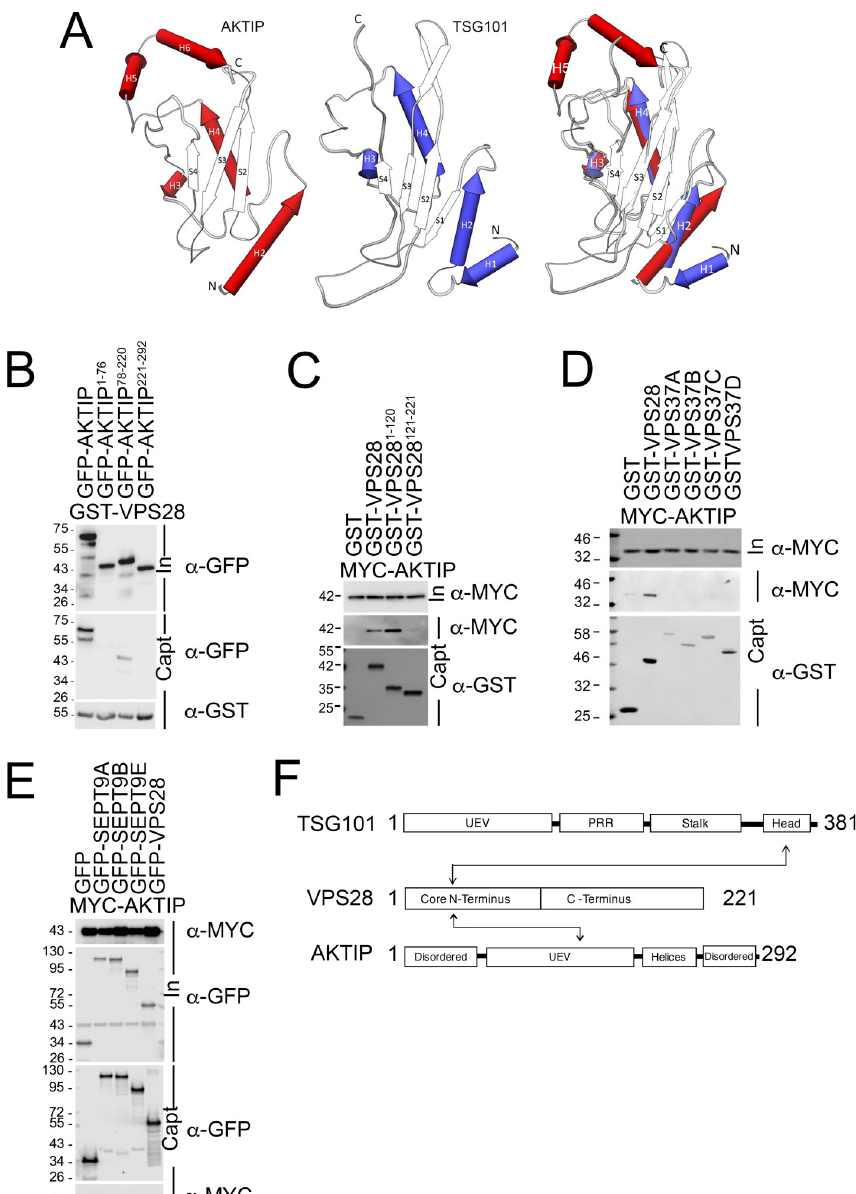
Fig 3. The central region of AKTIP interacts with the N-terminus of VPS28. (A) Superimposing of AKTIP model on TSG101 X-ray solved structure highlights similarities in the central region and two main different elements outside of it. Namely, the AKTIP central UEV domain presents two C-terminal helices (H5 and H6), absent in TSG101; TSG101 contains two N-terminal helices (H1 and H2), while AKTIP only one (H2). (B-C) Western blotting showing that central UEV region of AKTIP interacts with GST-VPS28 (B) and that AKTIP interacts with N-terminal domain of VPS28 (C). Cells were transfected with plasmids encoding the indicated fusion proteins and the AKTIP protein N- terminal (1–76 aa, NT), central domain (78–220 aa), C-terminal (221–292 aa) fragments. Purified VPS28-GST, or N- terminal (1–120 aa, NT) VPS28, or C-terminal (121-221aa, CT) or GST alone were used to pull down interacting proteins; cell lysates and glutathione-bound fractions were then analyzed with GST, GFP or MYC antisera. GST-pull downs were repeated three times. (D) Western blotting showing that AKTIP does not interact with VPS37 A to D isotypes and confirming its interaction with VPS28. Cells were transfected with plasmids encoding the indicated fusion proteins. Purified VPS28-GST or VPS37(A-D)-GST or GST alone were used to pull down interacting proteins; cell lysates and glutathione-bound fractions were then analyzed with MYC antisera. GST-pull downs were repeated two times. (E) Western blotting showing that AKTIP does not interact with SEPT9 (A, B and E) and confirming its interaction with VPS28. Cells were transfected with the indicated fusion proteins. Purified SEPT9 (isoforms A, B